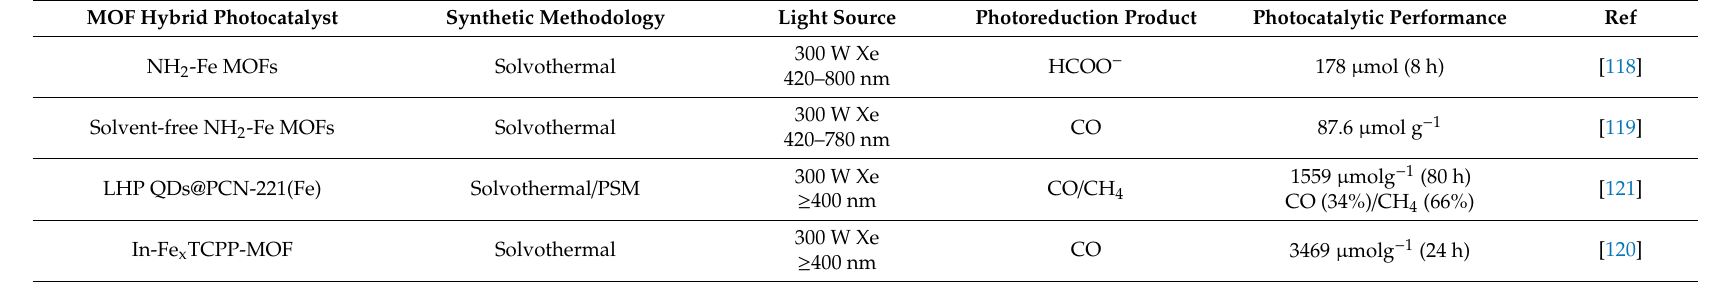
Table 4. Non-noble-metal species incorporated within MOFs for photocatalytic CO 2